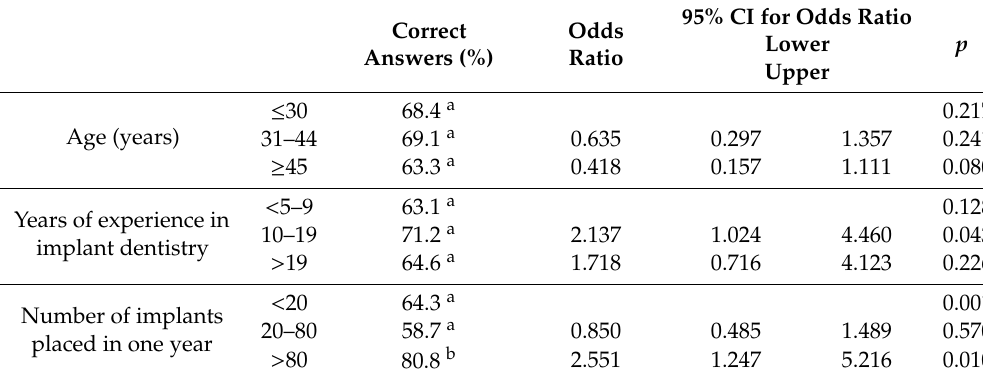
Multivariable analysis considering the correct answers on the treatment of retrograde